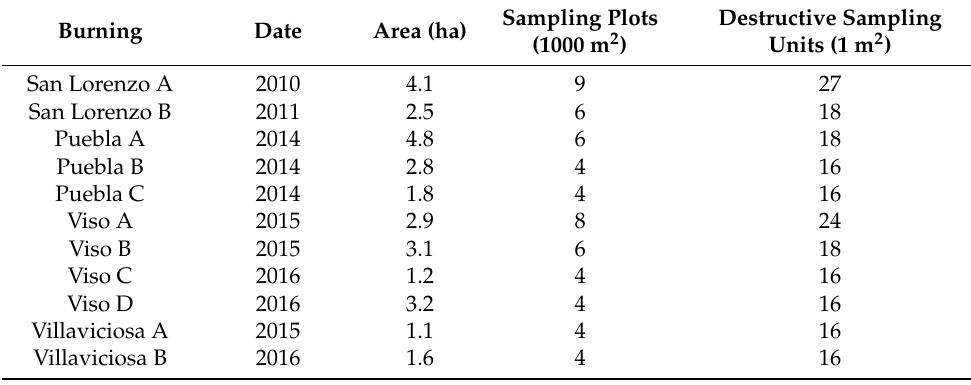
Table A1. Area and number of sampling plots and destructive sampling units for each prescribed fire.